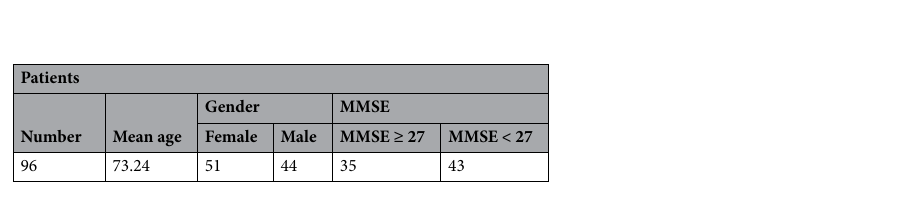
Table 2. Characterisation of patients with available information at time of